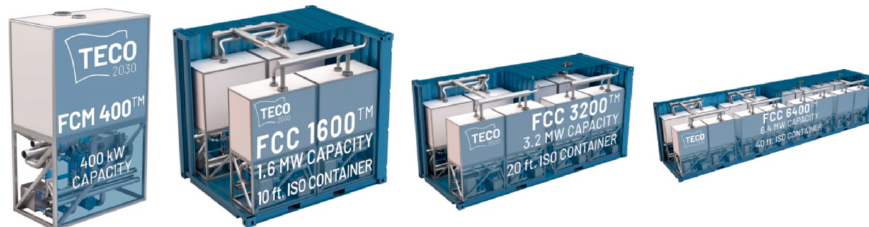
Figure 14. Series of marine fuel cells produced by TECO 2030 [78].